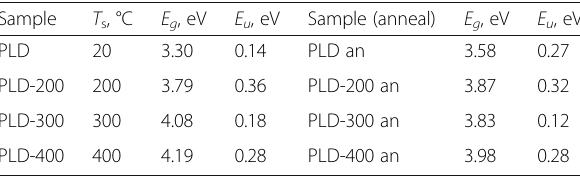
Table 1 The variation of bandgap energy and Urbach ’ s energy of ZnO thin